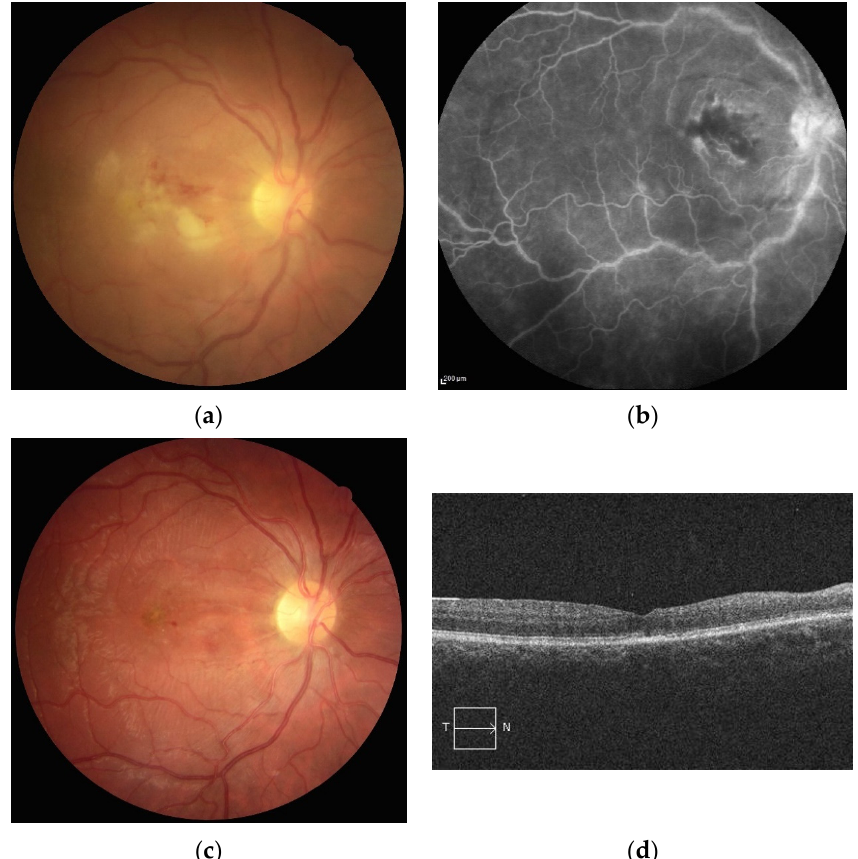
Figure 1. ( a ) Retinal photography of the right eye of a patient with Behçet’s disease showing a white infiltrate in the inter-papillomacular area associated with retinal edema and hemorrhage. ( b ) Fluorescein angiography showing vascular staining in the involved area. ( c ) Two months later, retinal photography showing retinal and optic atrophy with resolution of the infiltrate. ( d ) Two months later, spectral domain OCT scan showing atrophy of the inner retinal layers.